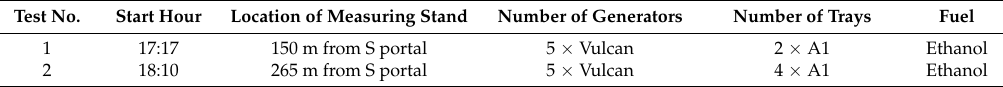
Table 2. The variations of wind velocity and wind direction during the tests.